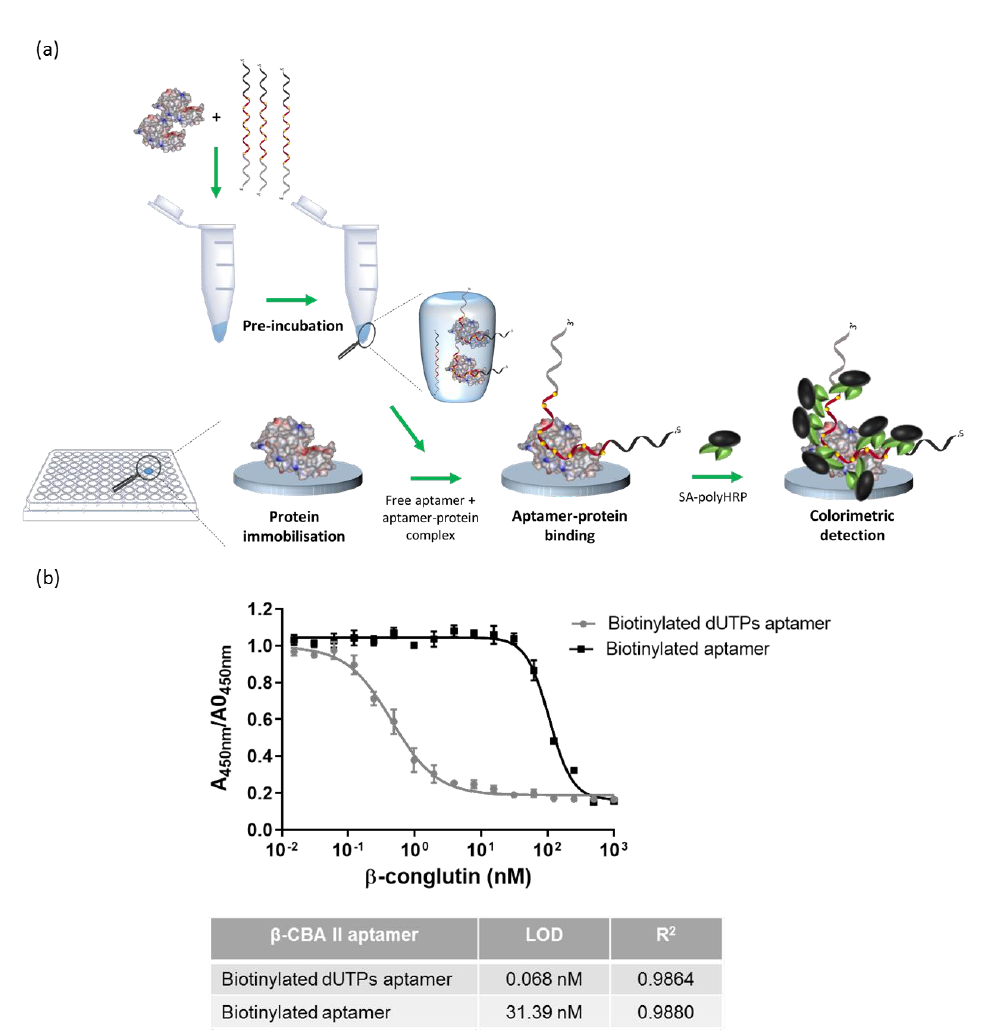
Figure 3. Competition assay on microtiter plate: ( a ) schematic representation of the assay; ( b ) calibration curves comparing modified biotinylated dUTPs aptamer and aptamer bearing a single biotin label (biotinylated